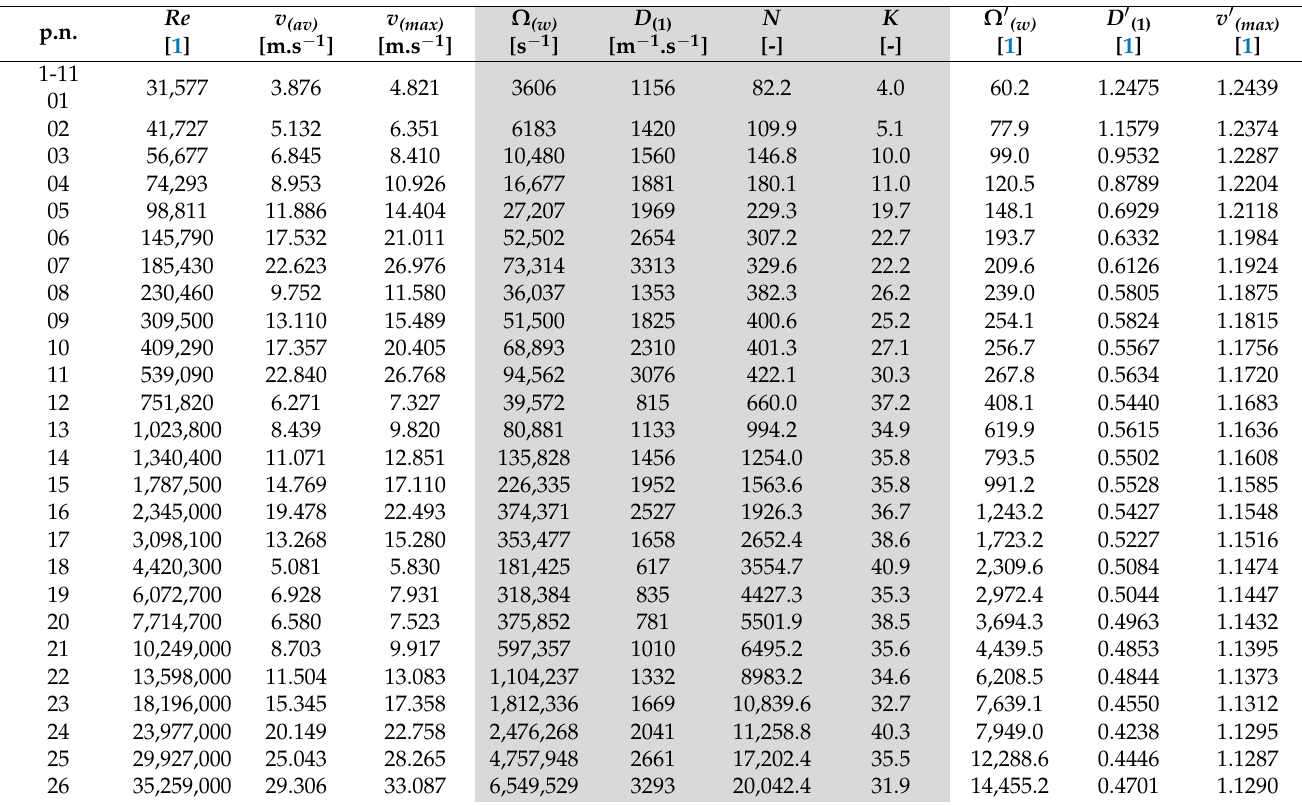
Table 2. Parameters of the analytical velocity profile. Quantities Ω (w) , D (1) , N , and K are obtained from comparison with the experimental data.